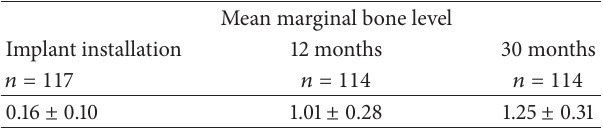
Table 1: Peri-implant mean marginal bone levels ( 𝑛 : number of implants).